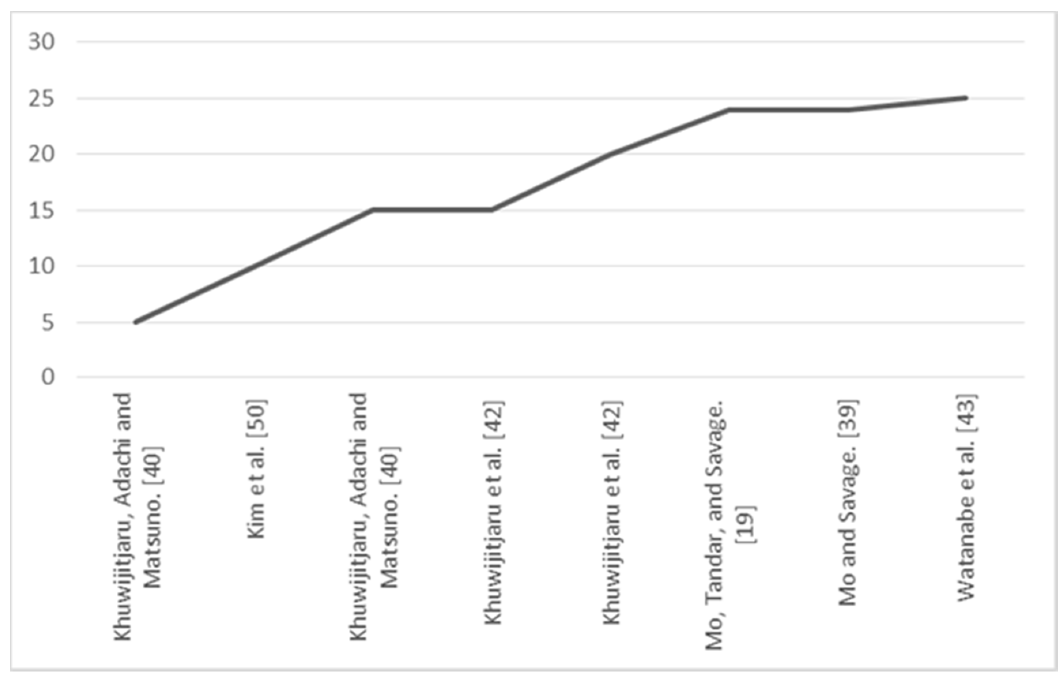
Figure 13. Pressure (MPA) in hydrothermal experiments with fatty acids.